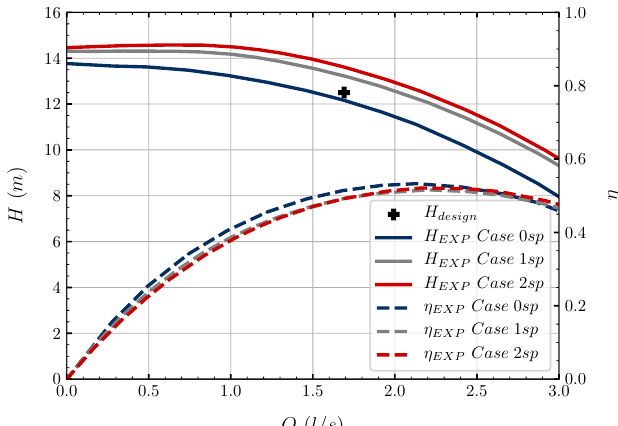
Figure 10. Experimental results for the 3 tested